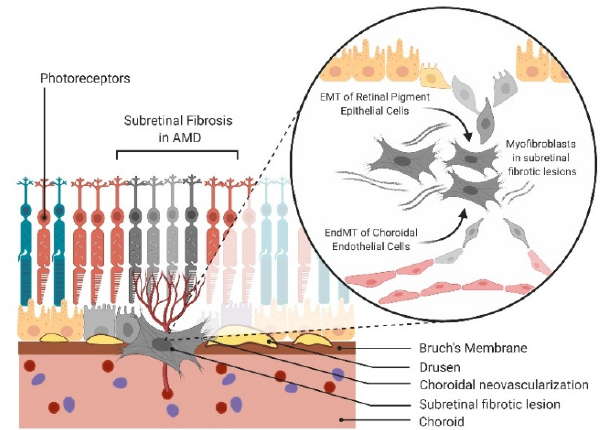
Figure 1. Epithelial-mesenchymal transition (EMT) and endothelial-mesenchymal transition (EndMT) in age-related macular degeneration (AMD). Schematic of EMT of retinal pigment epithelial (RPE) cells and EndMT of choroidal endothelial cells (CECs) contributing to the mesenchymal cell population in subretinal fibrosis of AMD.